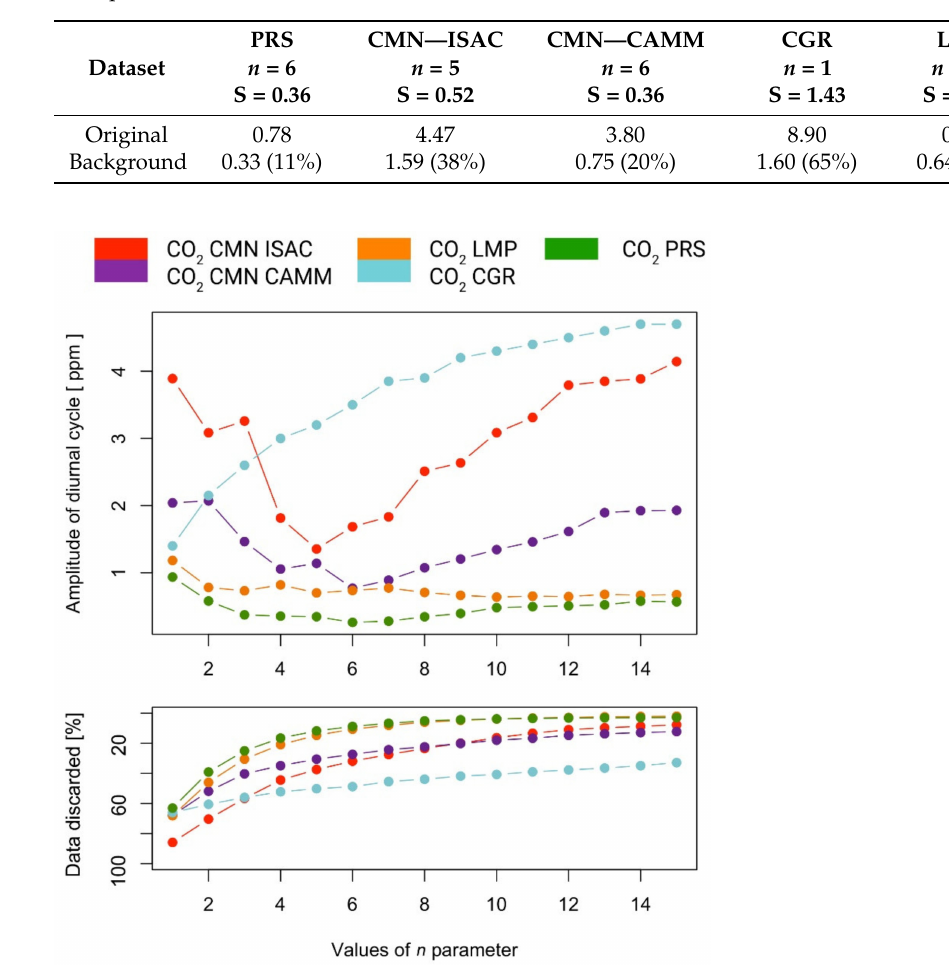
Table 2. Median amplitude of the diurnal variation (expressed in ppm) and percent of data removed (in brackets) for each measurement site. The values of S and of the retrieved optimal n parameters are reported for each site.